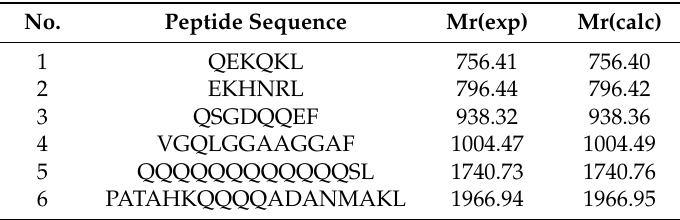
Table 1. Peptides from sub-fraction F5-3 identified by electrospray ionisation tandem mass spectrometry (ESI-MS/MS).